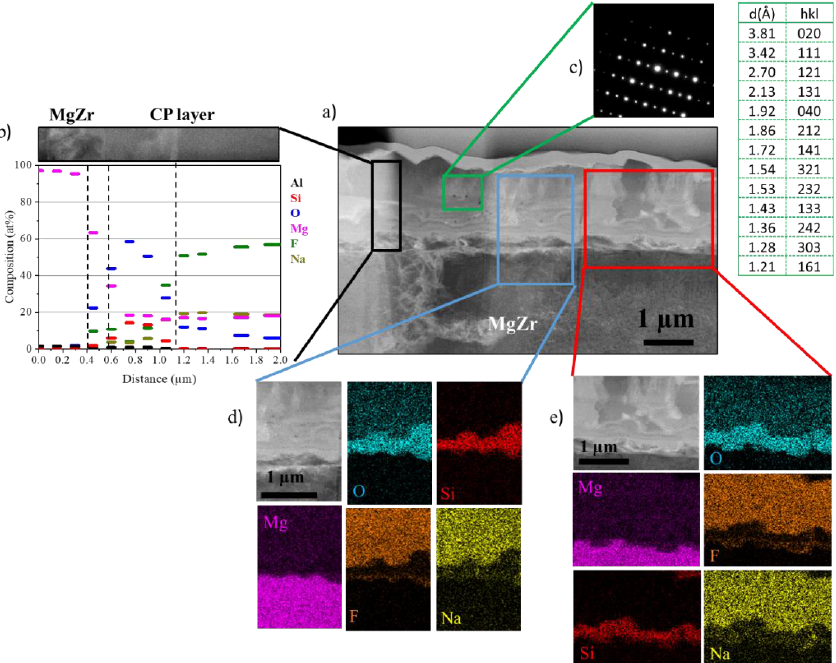
Figure 6. ( a ) Image of CP layer of MgZr substrate corroded in NaF-SP during 360 days in DF-STEM mode, ( b ) elementary profile obtained in CP layer from EDX analysis (black rectangle), ( c ) electron diffraction of the phase having cubic shape identified as NaMgF 3 (green rectangle), ( d , e ) EDX cartographies of two zones (red and blue rectangles).